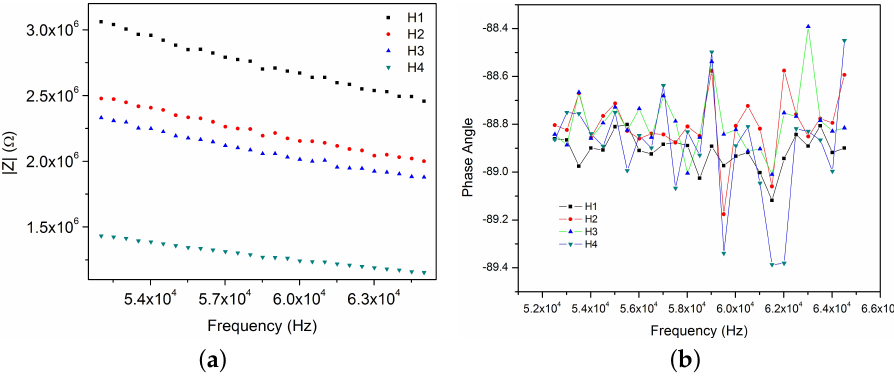
Figure 10. Bode diagrams of coplanar plates capacitors of empty device (NCA) ( a ) Impedance and ( b ) Phase angle.